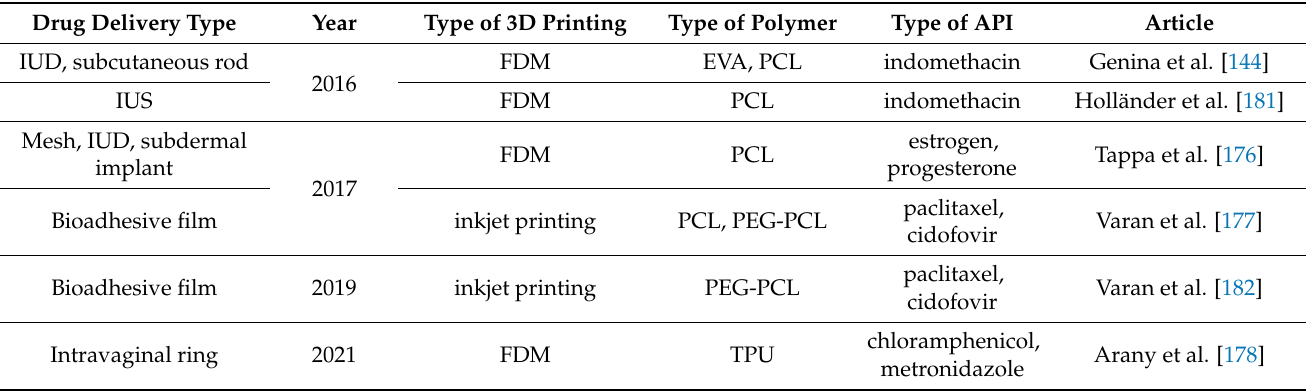
Table 8. The grouping of the manufactured vaginal drug delivery systems based on the publication year and then in alphabetical